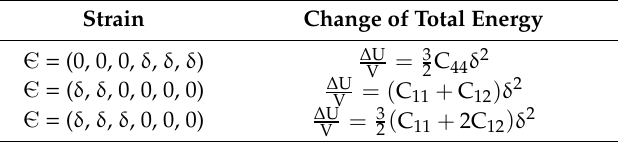
Table 3. The relationship between the strains ( δ ) and the total energy changes ( ∆ U) of BCC metal. Strain Change of Total Energy